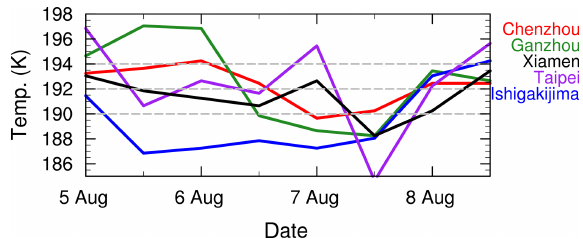
Figure 6. The time series of the lowest temperature in the tropopause layer for Chenzhou, Ganzhou, Xiamen, Taipei, and Ishi-